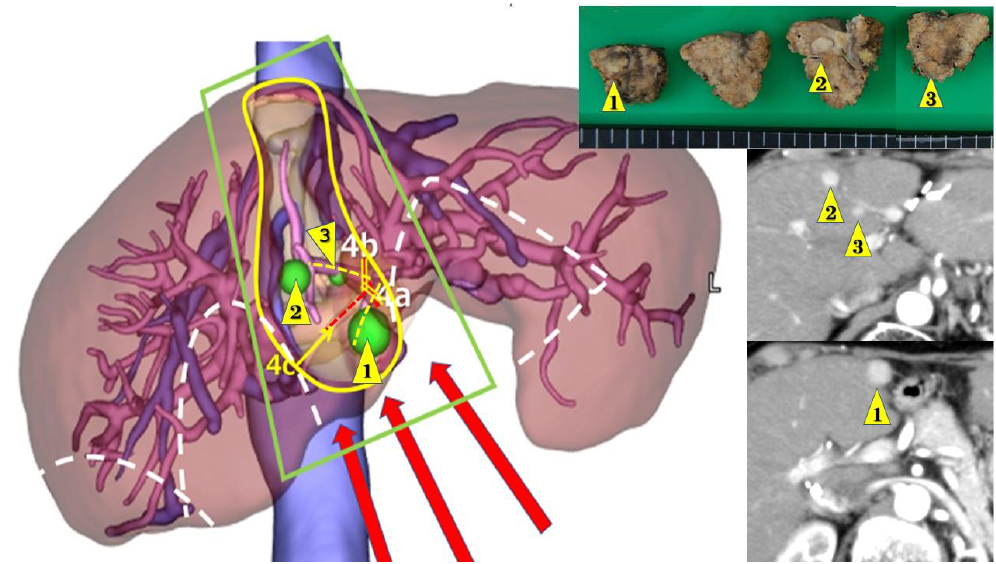
Figure 2. Simulation for fourth laparoscopic liver resection of three tumors in segment 4. Three tumors (1,2, and 3) all developed in segment 4 after segment 3 segmentectomy (1st laparoscopic liver resection (LLR)), partial resection of segments 5–6 (2nd LLR) and partial resection of segments 1–7 (3rd LLR). Tumor 1 was in caudal area near the border of segments 4–3. Tumor 2 was in cranial surface area. Tumor 3 was in cranial dorsal area. Left: preoperative CT simulation from CT reconstruction. The area encircled with yellow line, which is the portal area of Glissonian pedicles 4a and 4b (yellow ruptured lines) and includes three tumors to be resected. Glissonian pedicle 4c (red ruptured line) is planned to be exposed and preserved on the bottom surface of transection. The areas encircled by white ruptured lines show the adhesion from previous surgeries. With the planned approach route shown with red arrows, the area encircled with green line is the planned surgical working space secured with minimum adhesiolysis. Right upper: resected specimen. Right lower: preoperative findings of computed tomography with